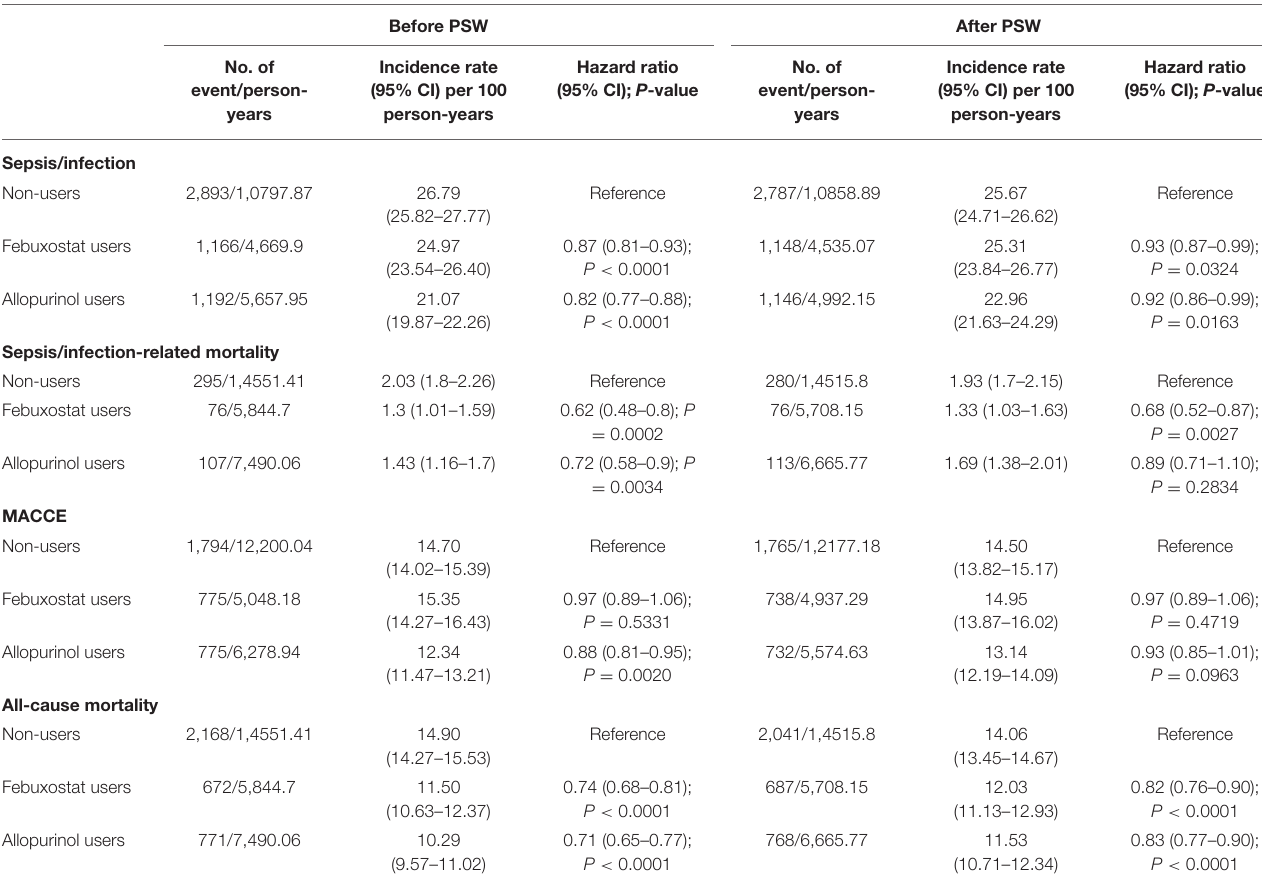
TABLE 2 | Outcome incidences and hazard ratios.